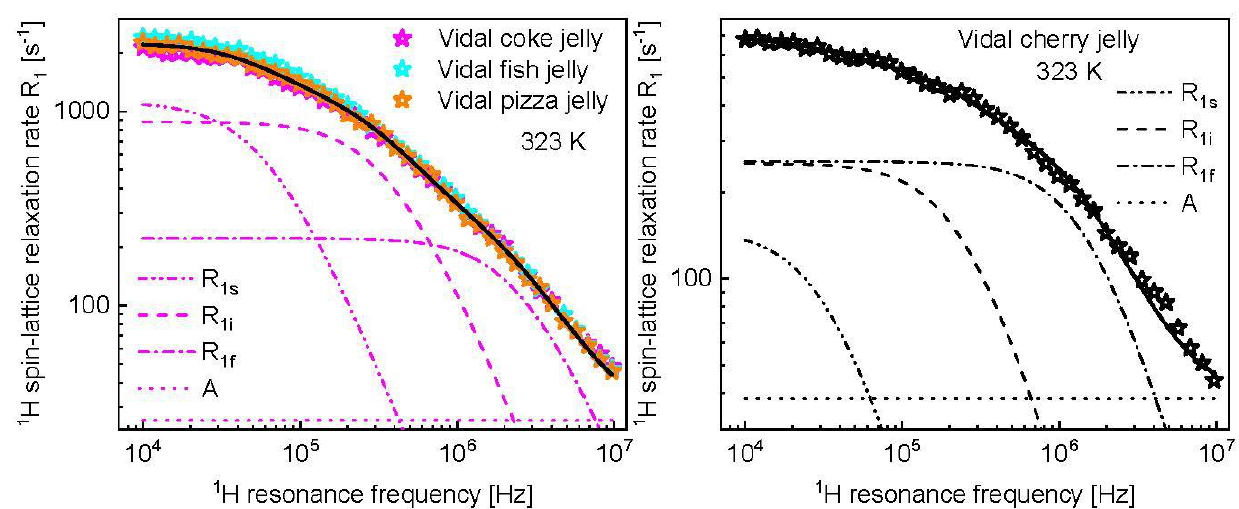
Figure 5. ( left ) 1 H spin-lattice relaxation rates for various kinds of Vidal jelly at 298 K compared